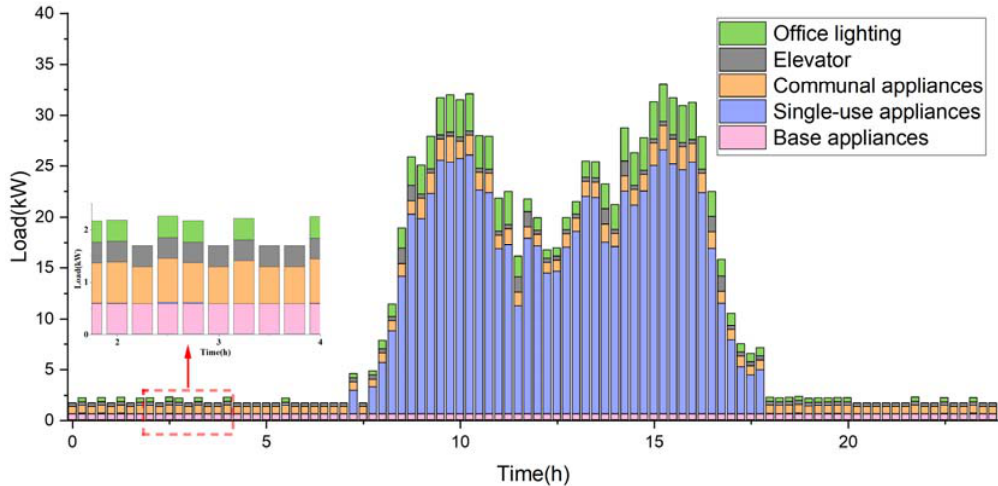
Figure 10. Electrical load distribution of a certain working day in the office building.